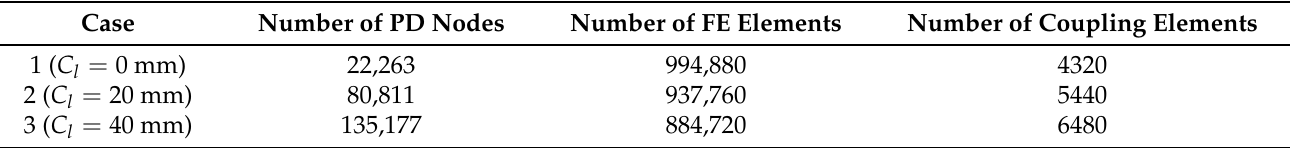
Table 2. Discretization information of the hybrid model for the notched beam specimens.